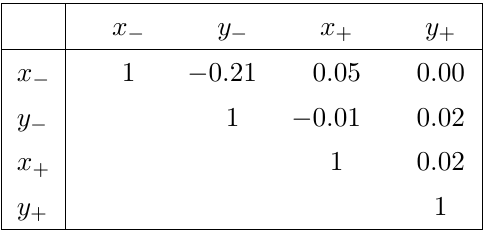
Table 1 . Statistical correlation matrix for the (cid:12)t to data.